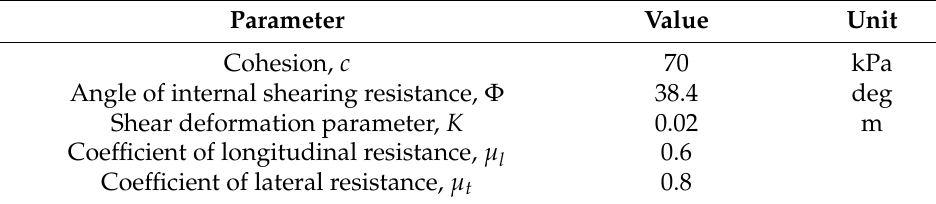
Table 2. Soil parameters for heavy clay